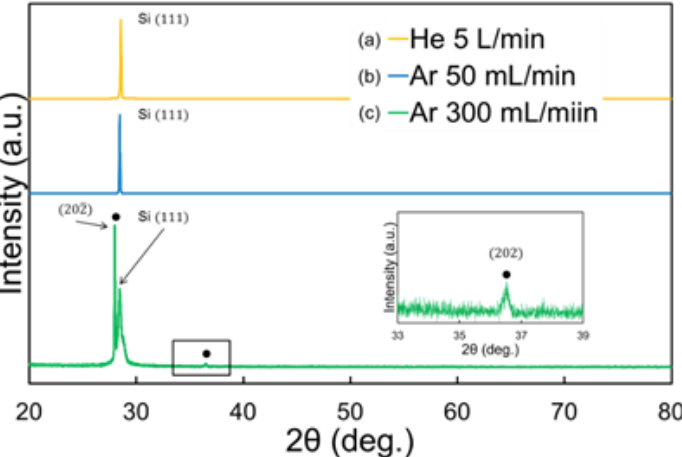
Figure 1. X-ray diffraction patterns of TiO 2 thin films deposited using the atmospheric pressure plasma jet technique with H 2 O vapor at fixed flow rate (500 mL/min) of titanium ethoxide precursor and ( a ) He = 5 L/min ( b ) He = 5L/min + Ar = 5 0mL/min and ( c ) He = 5L/min + Ar = 300 mL/min.